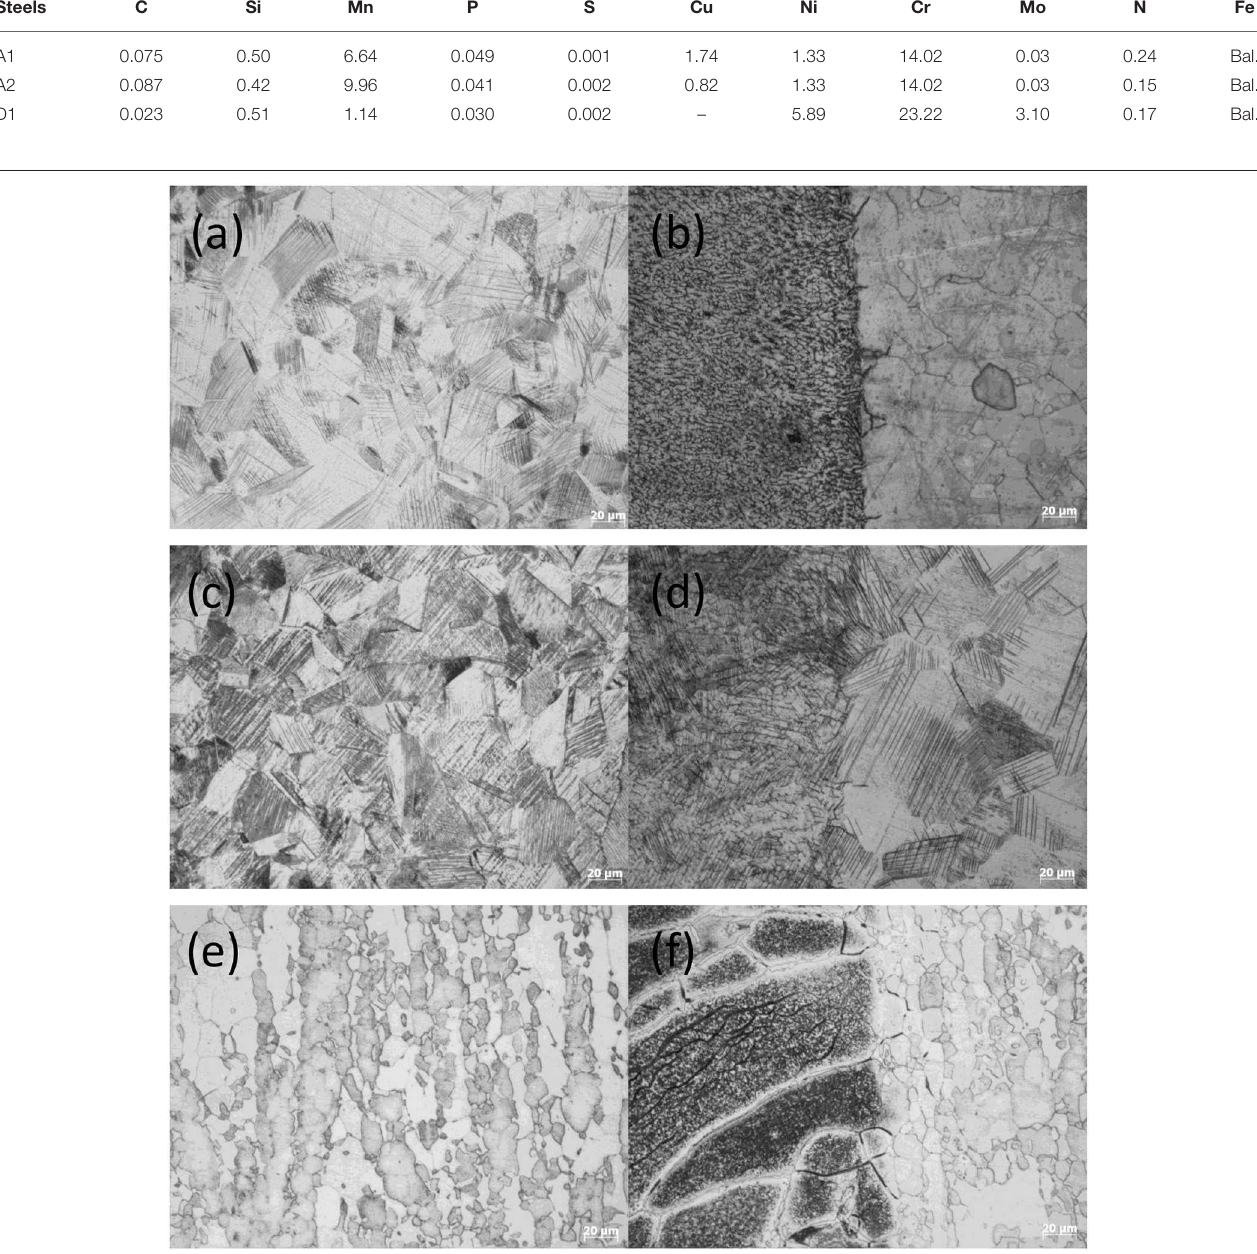
TABLE 1 | Chemical compositions of experimental steels (wt.%). Steels